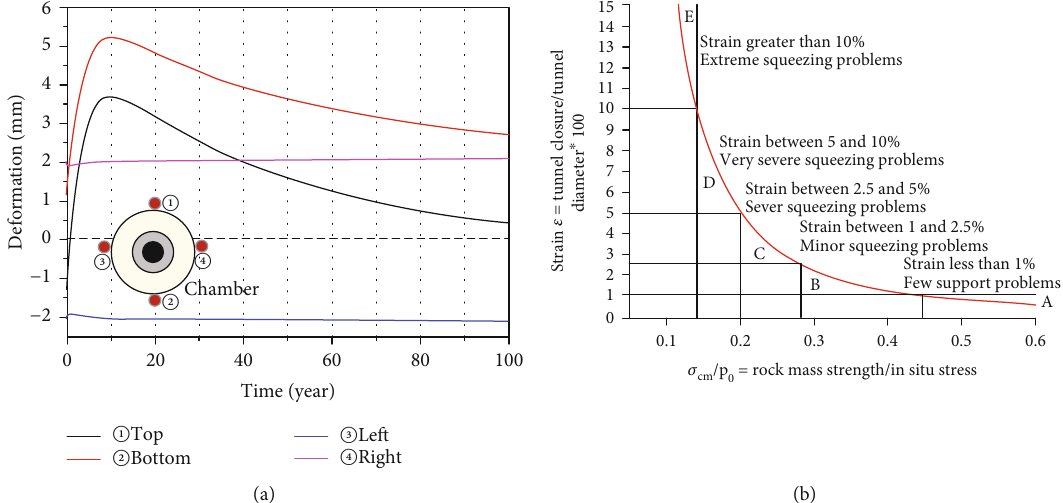
Figure 12: The relation of tunnel deformation with time and the criterion of stability: (a) The relation of tunnel deformation with time; (b) Criterion for judging deformation and global stability of surrounding